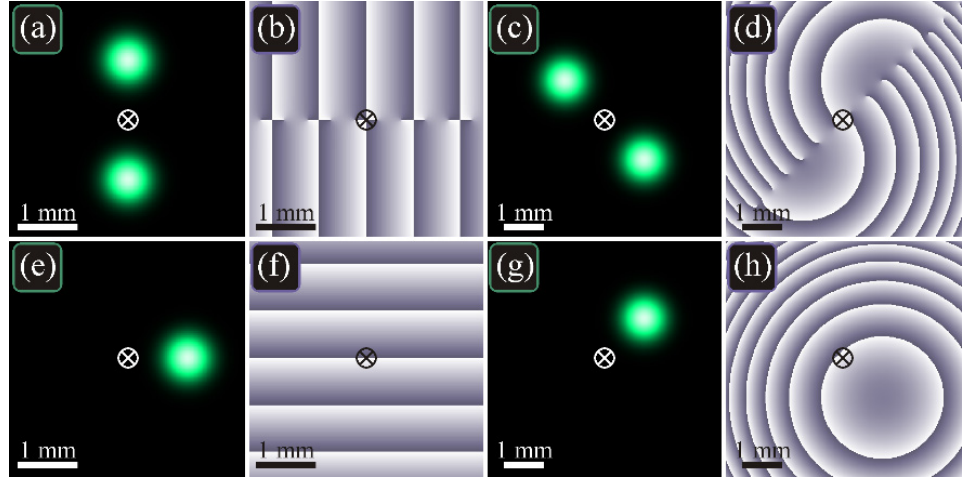
Figure 1. Intensity ( a , c , e , g ) and phase ( b , d , f , h ) distributions of the vortex cosine beam (3) and of the elementary spiral beam (4) in the initial plane ( a , b , e , f ) and at the Rayleigh distance ( c , d , g , h ) for the following parameters: wavelength λ = 532 nm, Gaussian beam waist radius w 0 = 0.5 mm, scaling factor α 0 = w 0 /4, computation domain | x |, | y | ≤ R with R = 2 mm (in the initial plane) and R = 3 mm (at the Rayleigh distance). The cross in the center shows the optical axis, around which the diffraction pattern rotates on propagation (at the Rayleigh distance, the rotation angle is π /4). If we denote 1/ α 0 = (2 q / w 2 )( x c − iy c ) with x c and y c being real numbers ( z -dependent),